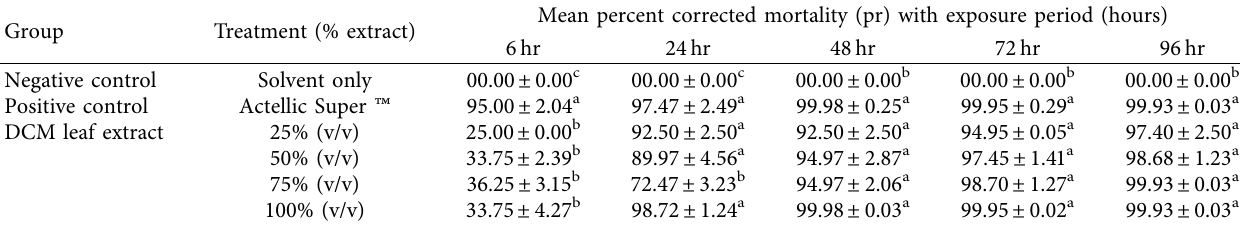
DCM and EtOAc used were of analytical grade (95.5%). Table 5: Contact toxicity effects of DCM leaf extracts of T. diversifolia against S. zeamais .